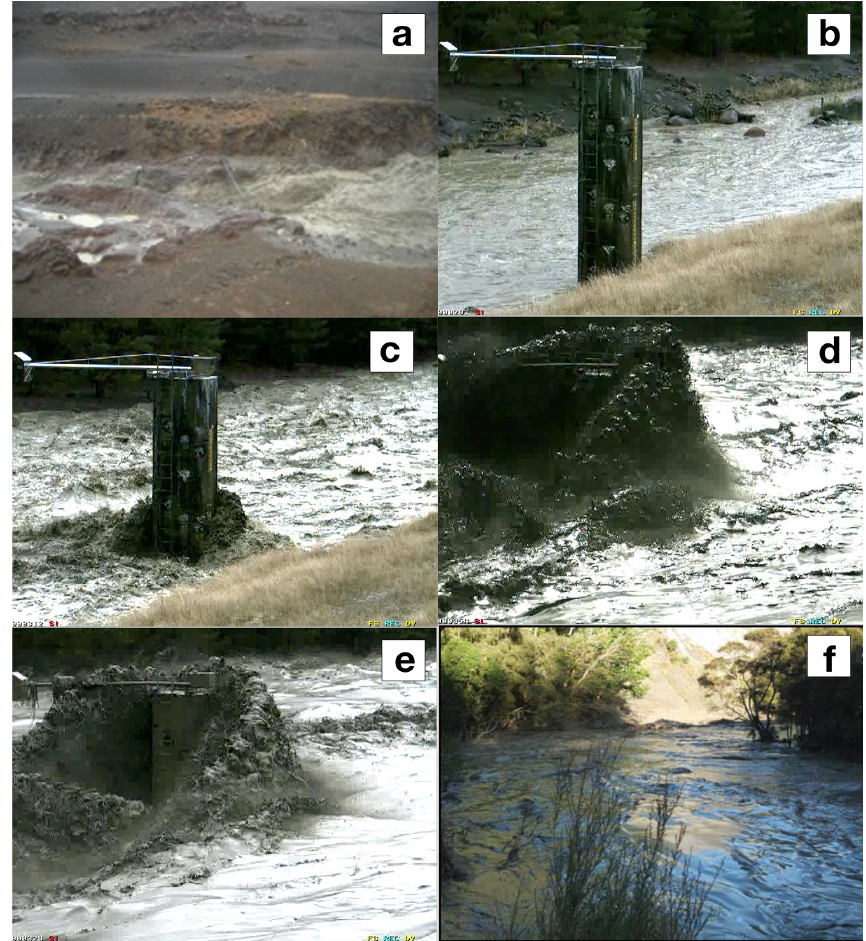
Figure 2. Images from the 18 March 2007 lake break-out lahar from RTMT (a) , TRAN (b–e) , and COLL (f) . Note the transformation of the lahar at TRAN from streamflow (b) , increased discharge pre-lahar phase 1 pulse/flow front (bow wave) (c) , head of the lahar (peak seismic amplitude) (d) , and low PSF beginning of the lahar body (see Fig. 4 after 15min mark) (e)